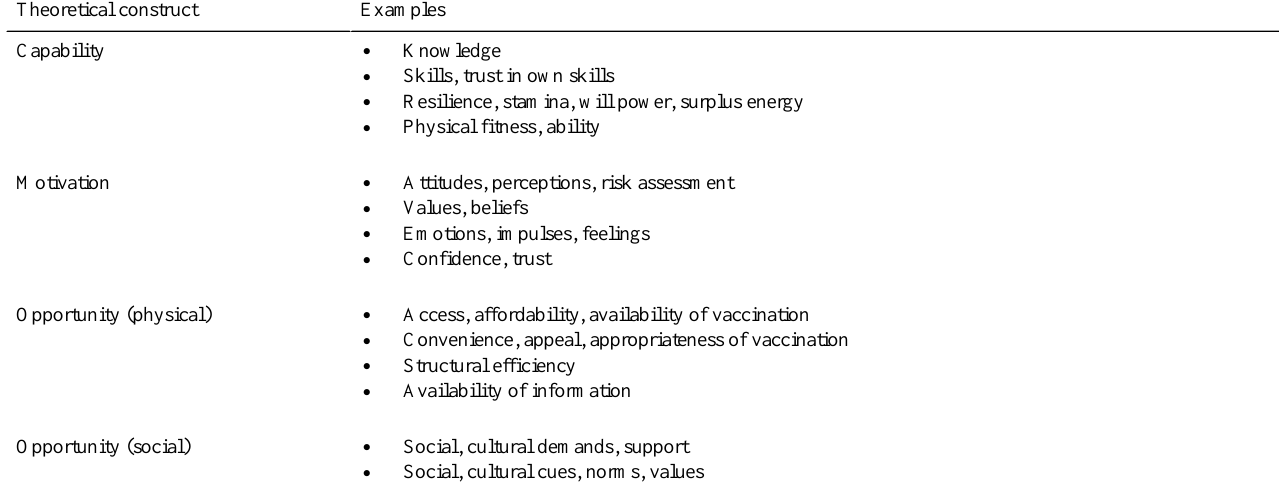
Table 1. The theoretical constructs in the adapted capability, opportunity, motivation–behavior (COM-B) model and associated examples by the World Health Organization Regional Office for